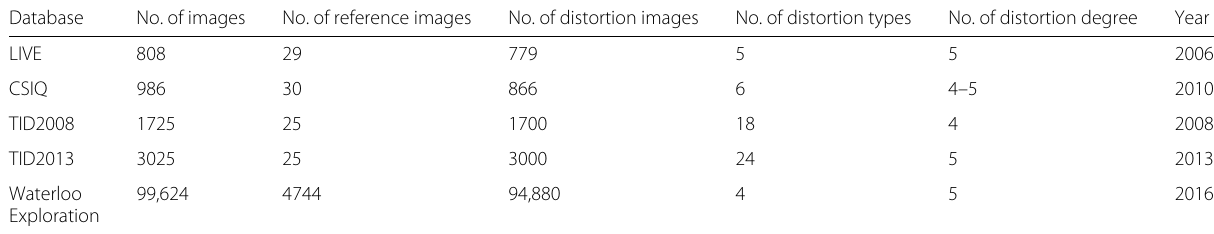
Table 1 Comparison of five IQA databases